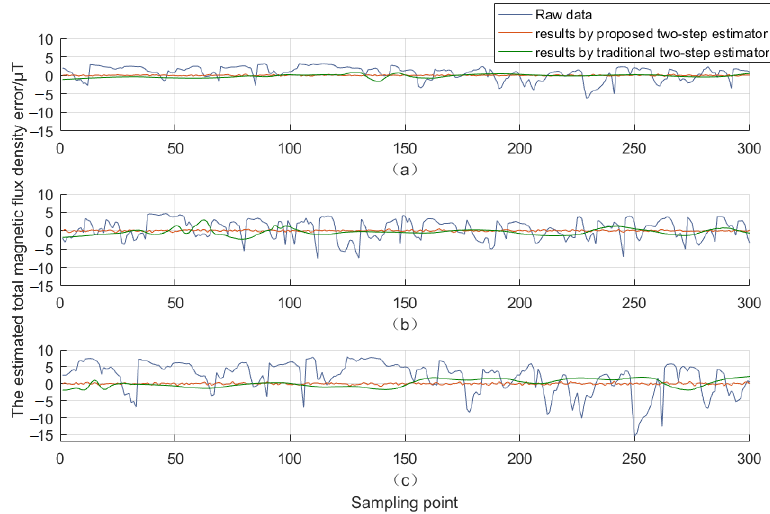
Figure 7. The estimated total magnetic flux density error. ( a ) the interference source radius is 90 cm; ( b ) the interference source radius is 70 cm; ( c ) the interference source radius is 50 cm.